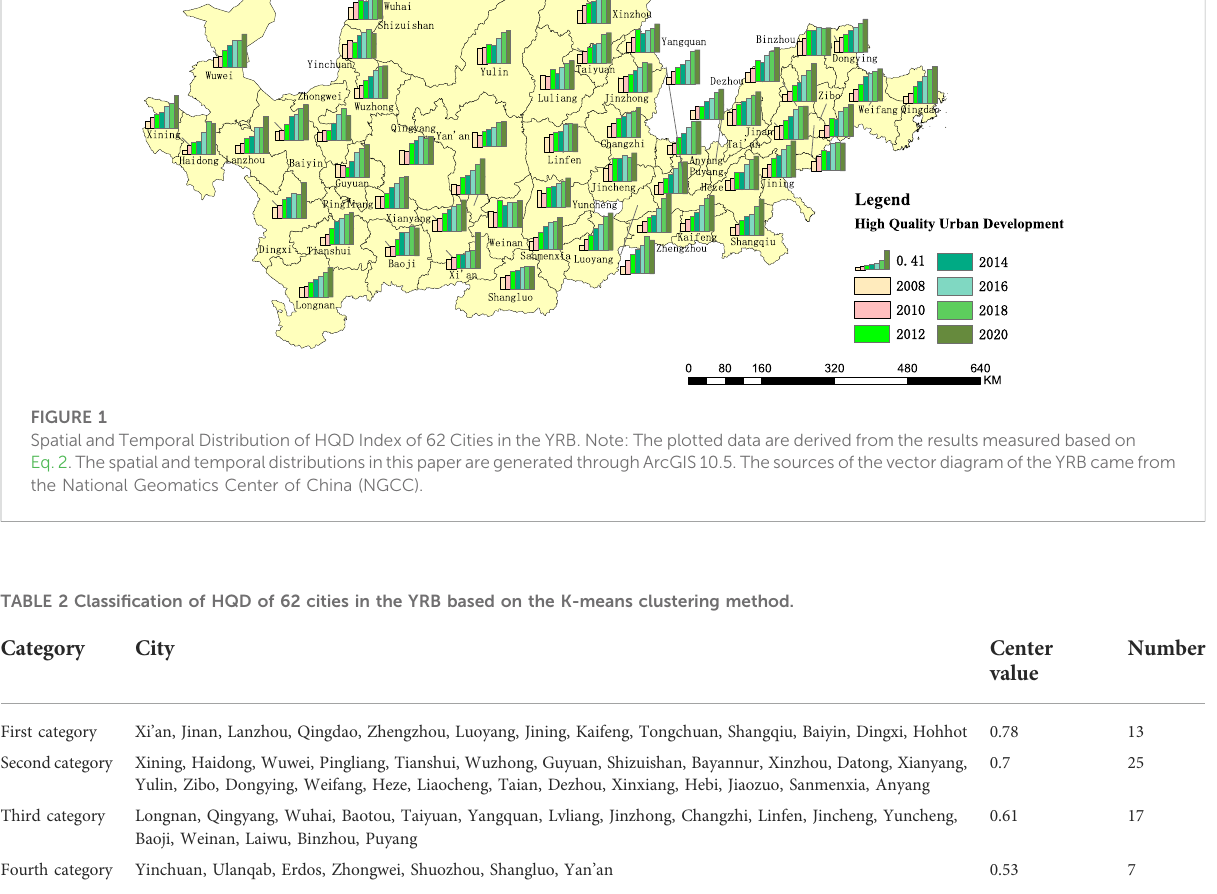
Figure 1. For the convenience of presentation, only the bar graphs of even years are listed.